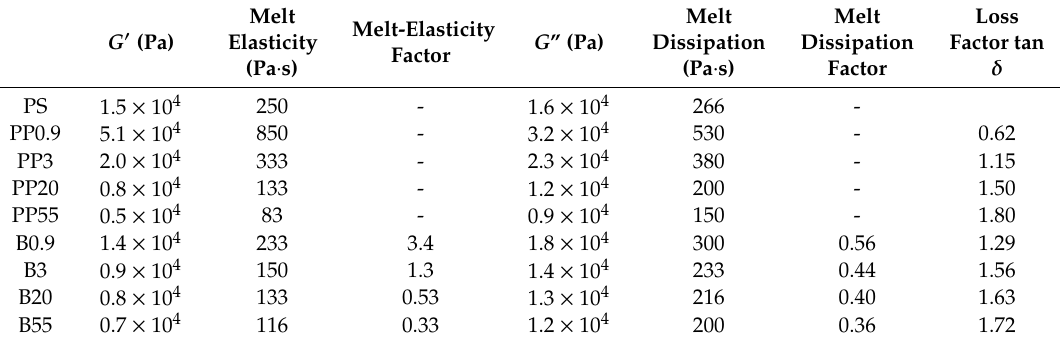
Table 7. Elasticity and dissipation factors of native polymers and blends under extrusion conditions (60 s − 1 , 200 ◦